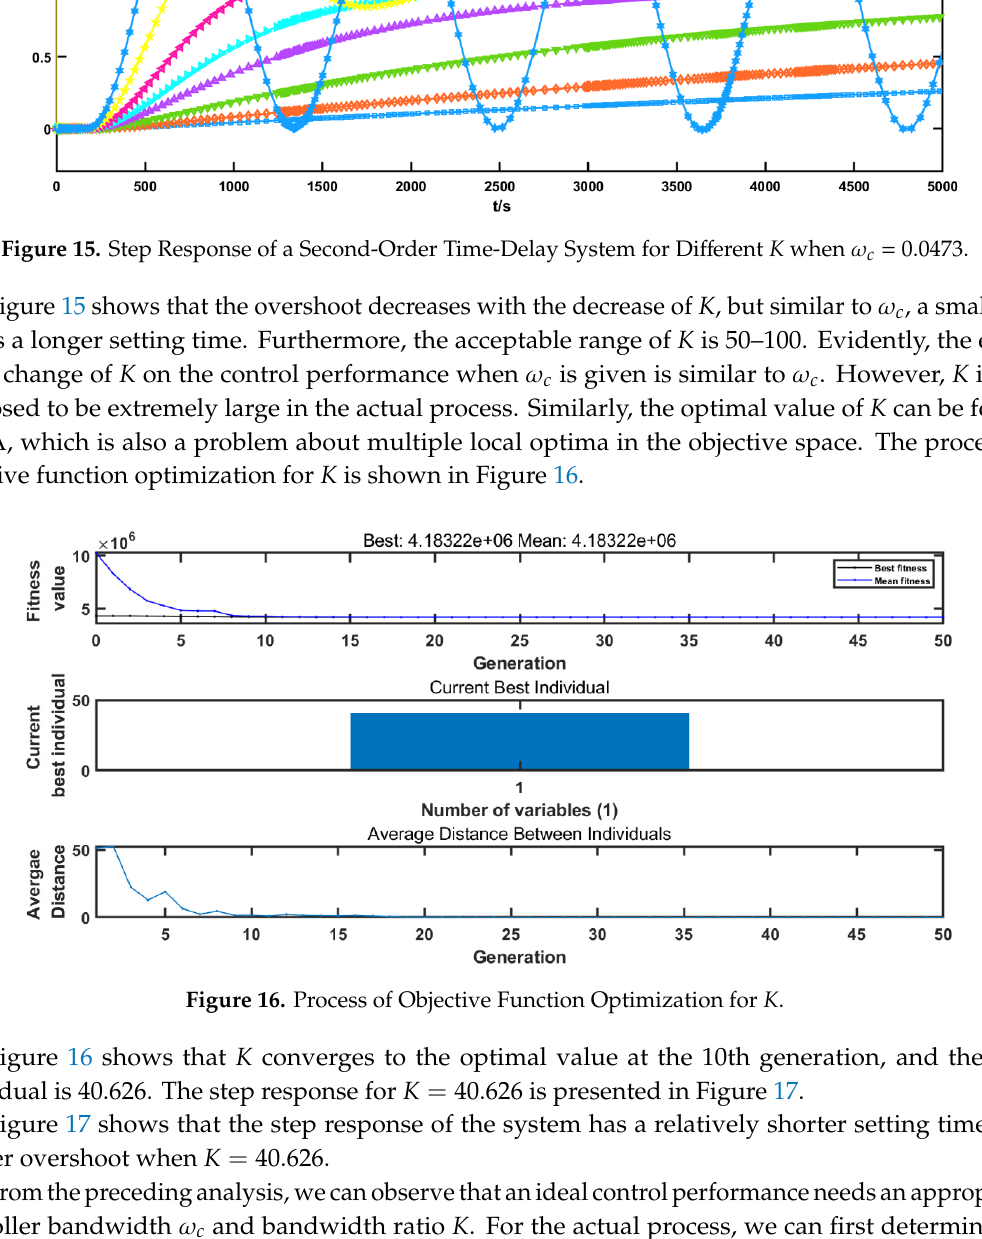
Figure 17. Step Response of Second-Order Time-Delay System for 𝜔 (cid:3030) = 0.0473 When 𝐾 = 40.626 .